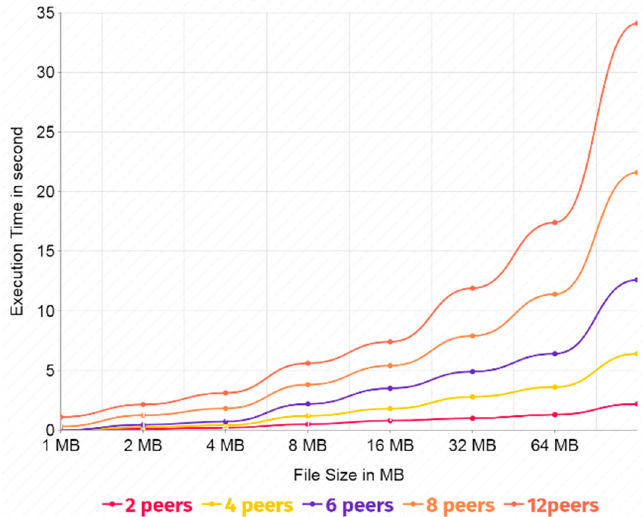
Figure 15. Execution time based on the number of peers and document size.